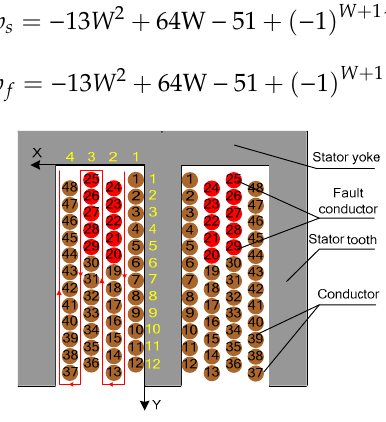
Figure 4. Turn distribution when the inter-layer fault occurs at (W = 2, Y = 5).